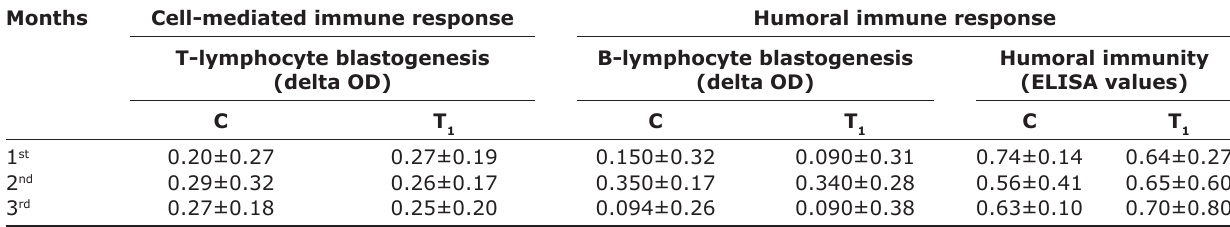
Table-4: Effect of CPF (mean±SE) on cell-mediated and humoral immune response in chicks. Months